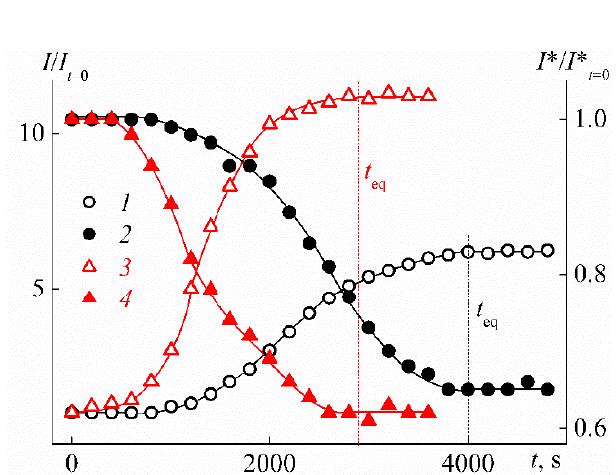
Figure 7. Dependencies of the relative values of light scattering intensity I / I t=0 (1, 3) and optical transmission I */ I * t=0 (2, 4) on time t for solutions with concentration c = 0.0280 g cm –3 of PEI-1 at T = 16 °С (1, 2) and PEI-2 at T = 21 °С (3, 4). I t=0 and I * t=0 are light scattering intensity and optical transmission at t = 0, respectively.